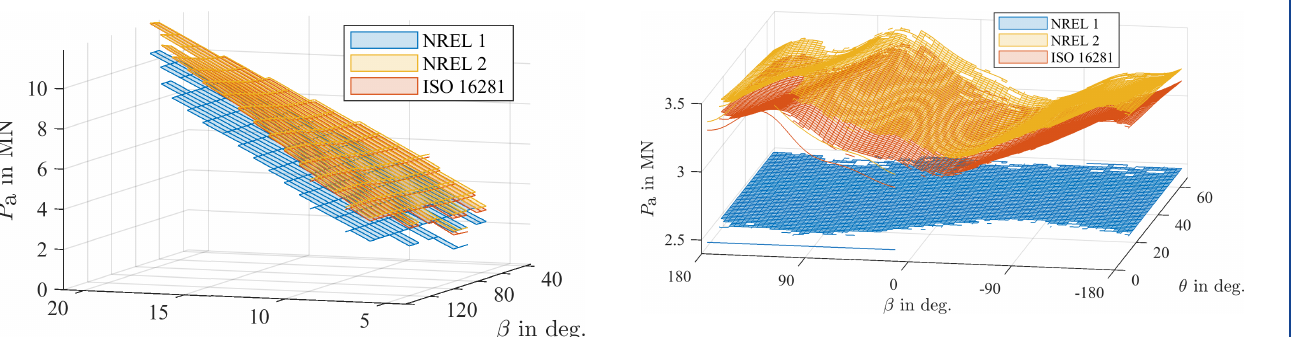
Figure 11. Equivalent loads P a for a fixed moment of M = 5MNm at operating points from the aeroelastic simulations.